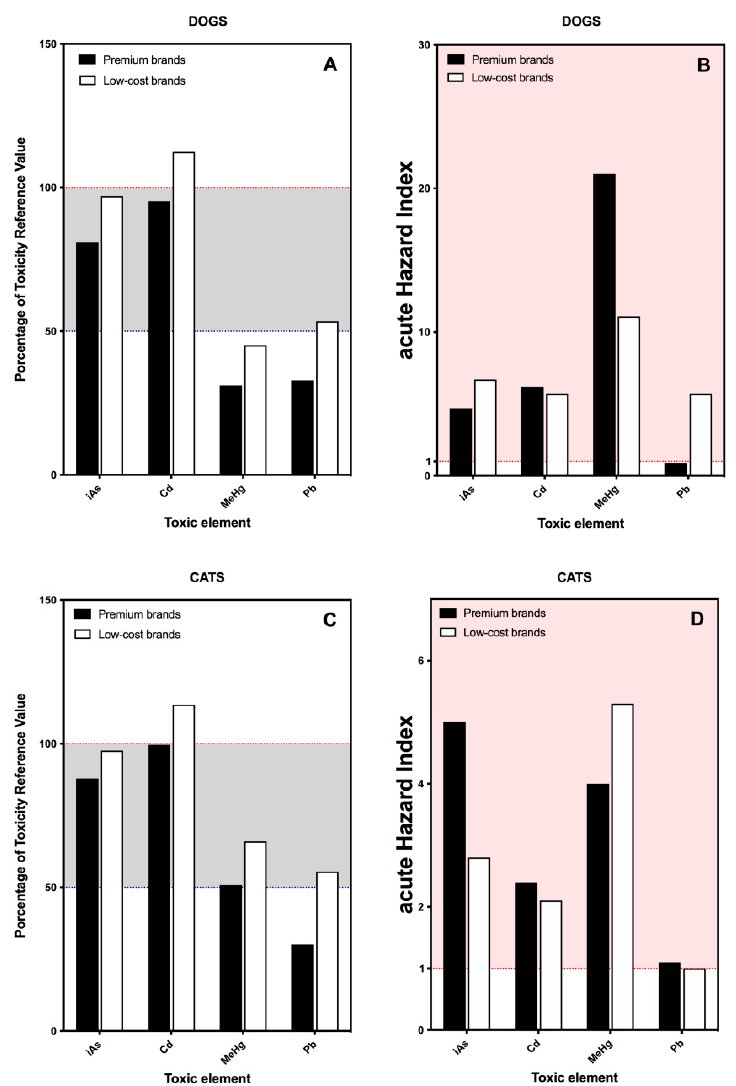
Figure 2. Bar plot indicating the percentage of the toxic reference value (TRV) and the acute Hazard Index (aHI) of toxic elements—arsenic (As), cadmium (Cd), mercury (Hg) and lead (Pb)—provided by the consumption of commercial dry food separated by the type of brand: premium vs. low-cost brands. ( A , B ) Results for dogs; ( C , D ) results for cats. Red dotted line indicates 100% of the TRV or the threshold for toxic effect for each